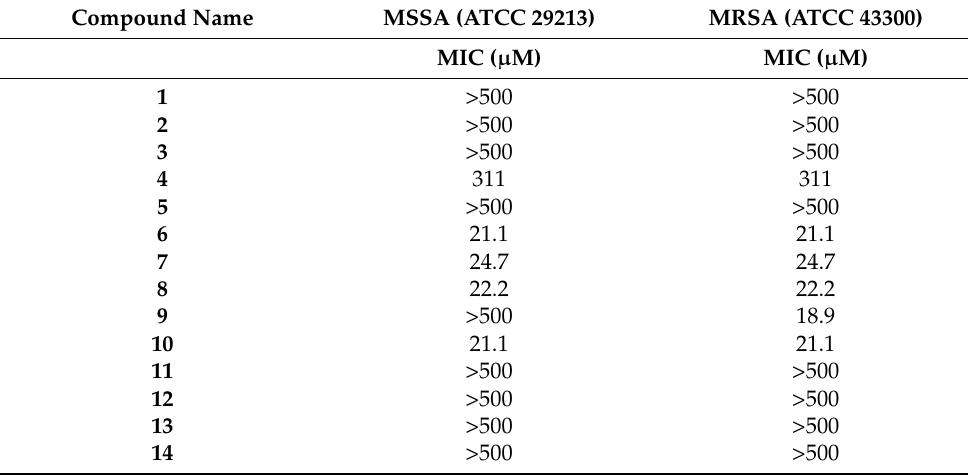
Table 1. Antimicrobial activity of compounds 1 – 14 .